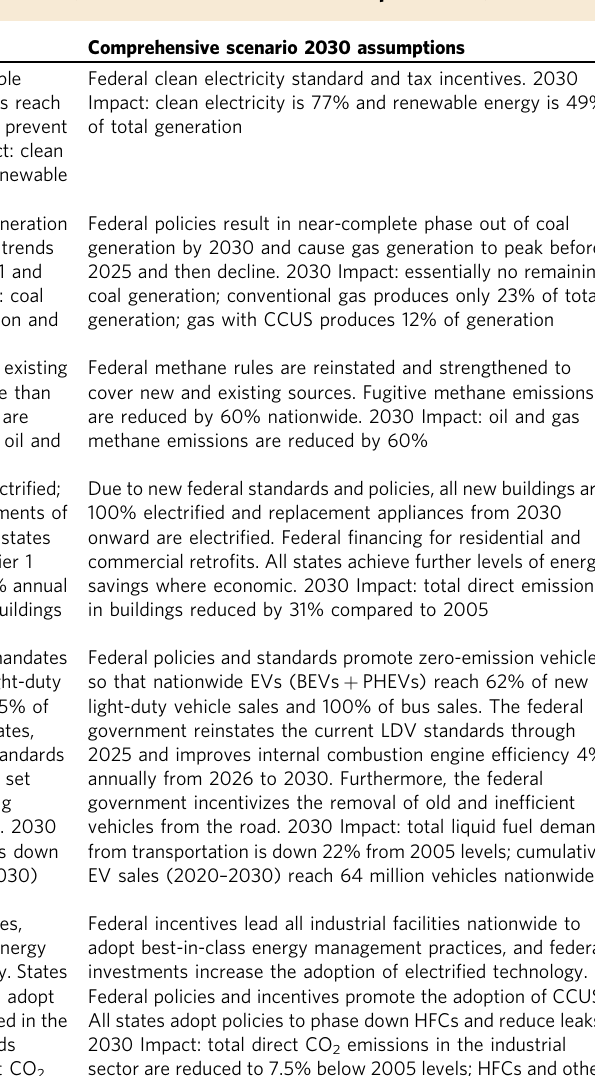
Table 2 Overview of assumptions for the higher-ambition U.S. scenarios (enhanced non-federal and